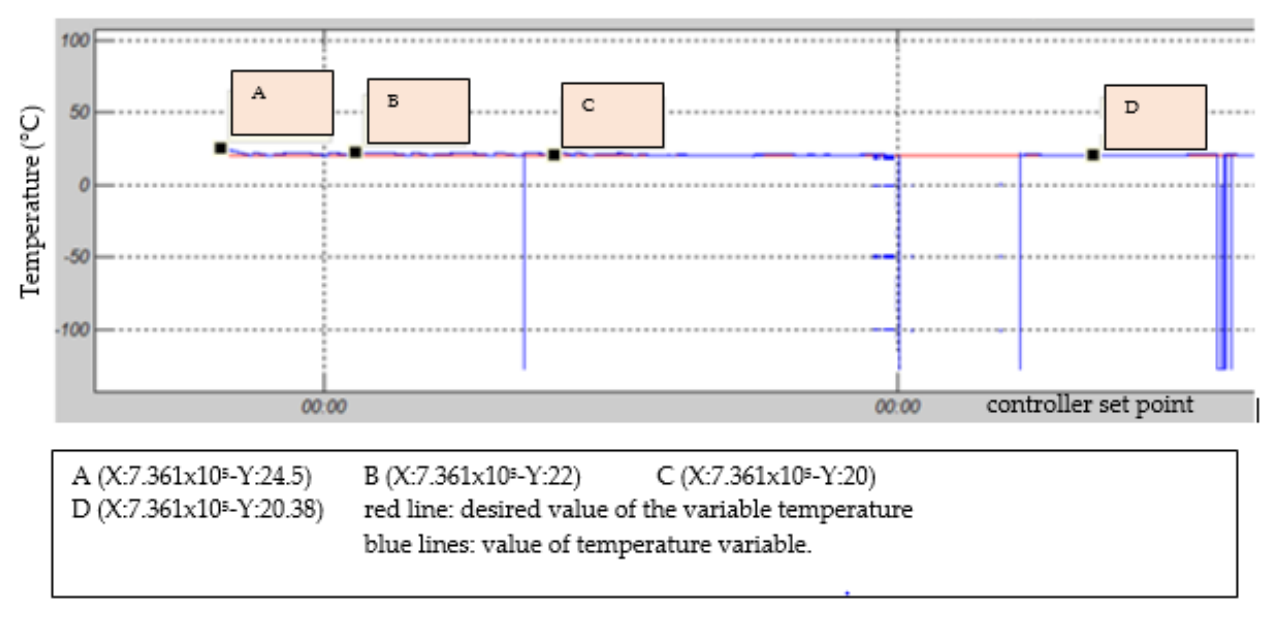
Figure 8. Temperature data for the water chamber of the T0 Biodigester [9]. The working temperature range of the T1 biodigester was 21–38 ◦ C, as shown in Figure 9.